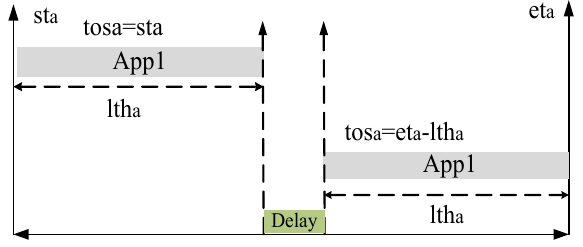
Figure 3. Two appliances’ example to show the connections among all